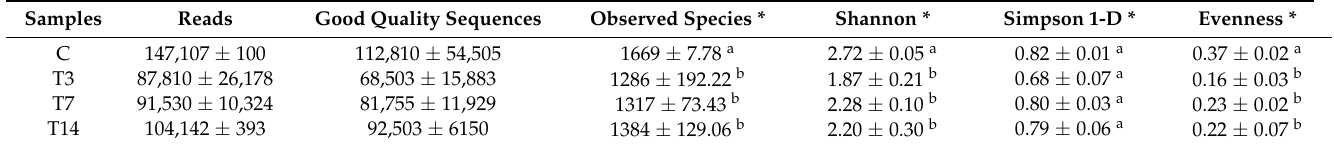
Table 2. Species richness and diversity indices of bacterial communities of control (C), T3, T7 and T14 soil samples.